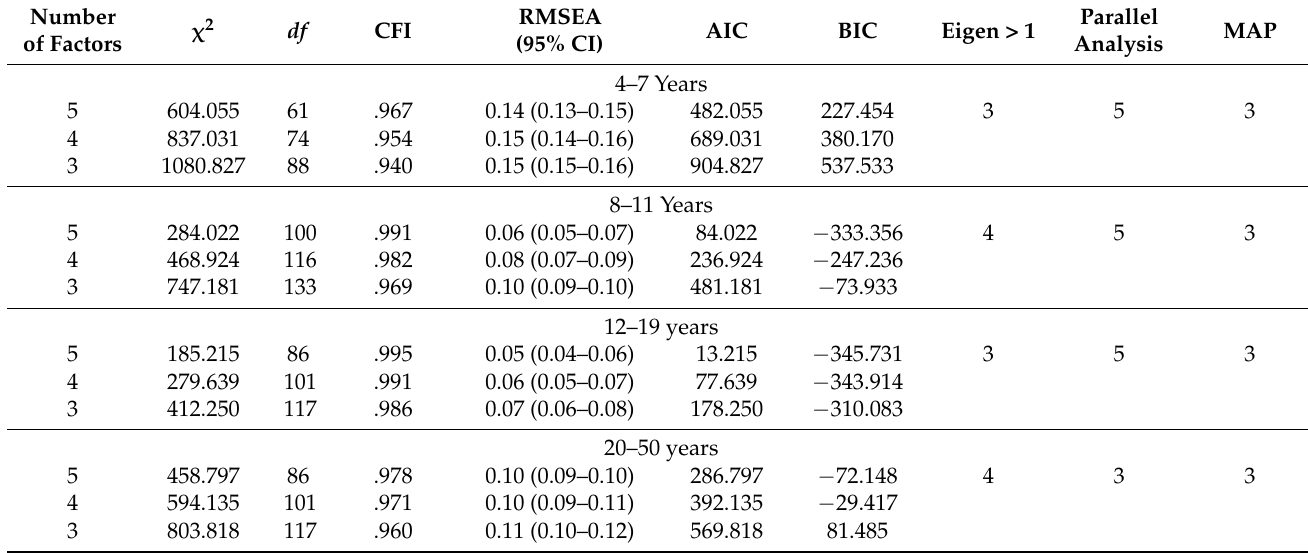
Table 2. Indices informing on number of factors to